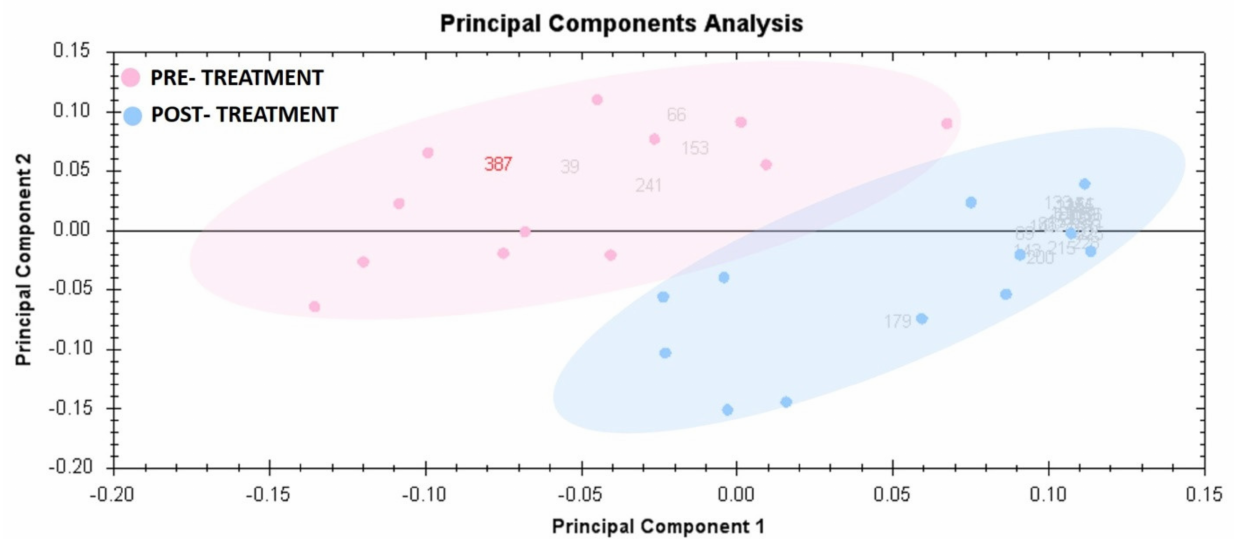
Figure 3. Principal component analysis of the proteomic dataset. Pink dots denote the 12 liraglutide pre-treated urine samples, and blue dots indicate the 12 liraglutide post-treated samples. Together, these explained 60.95% of the selected spots’ variability values. Colored dots and numbers represent gels and spots,